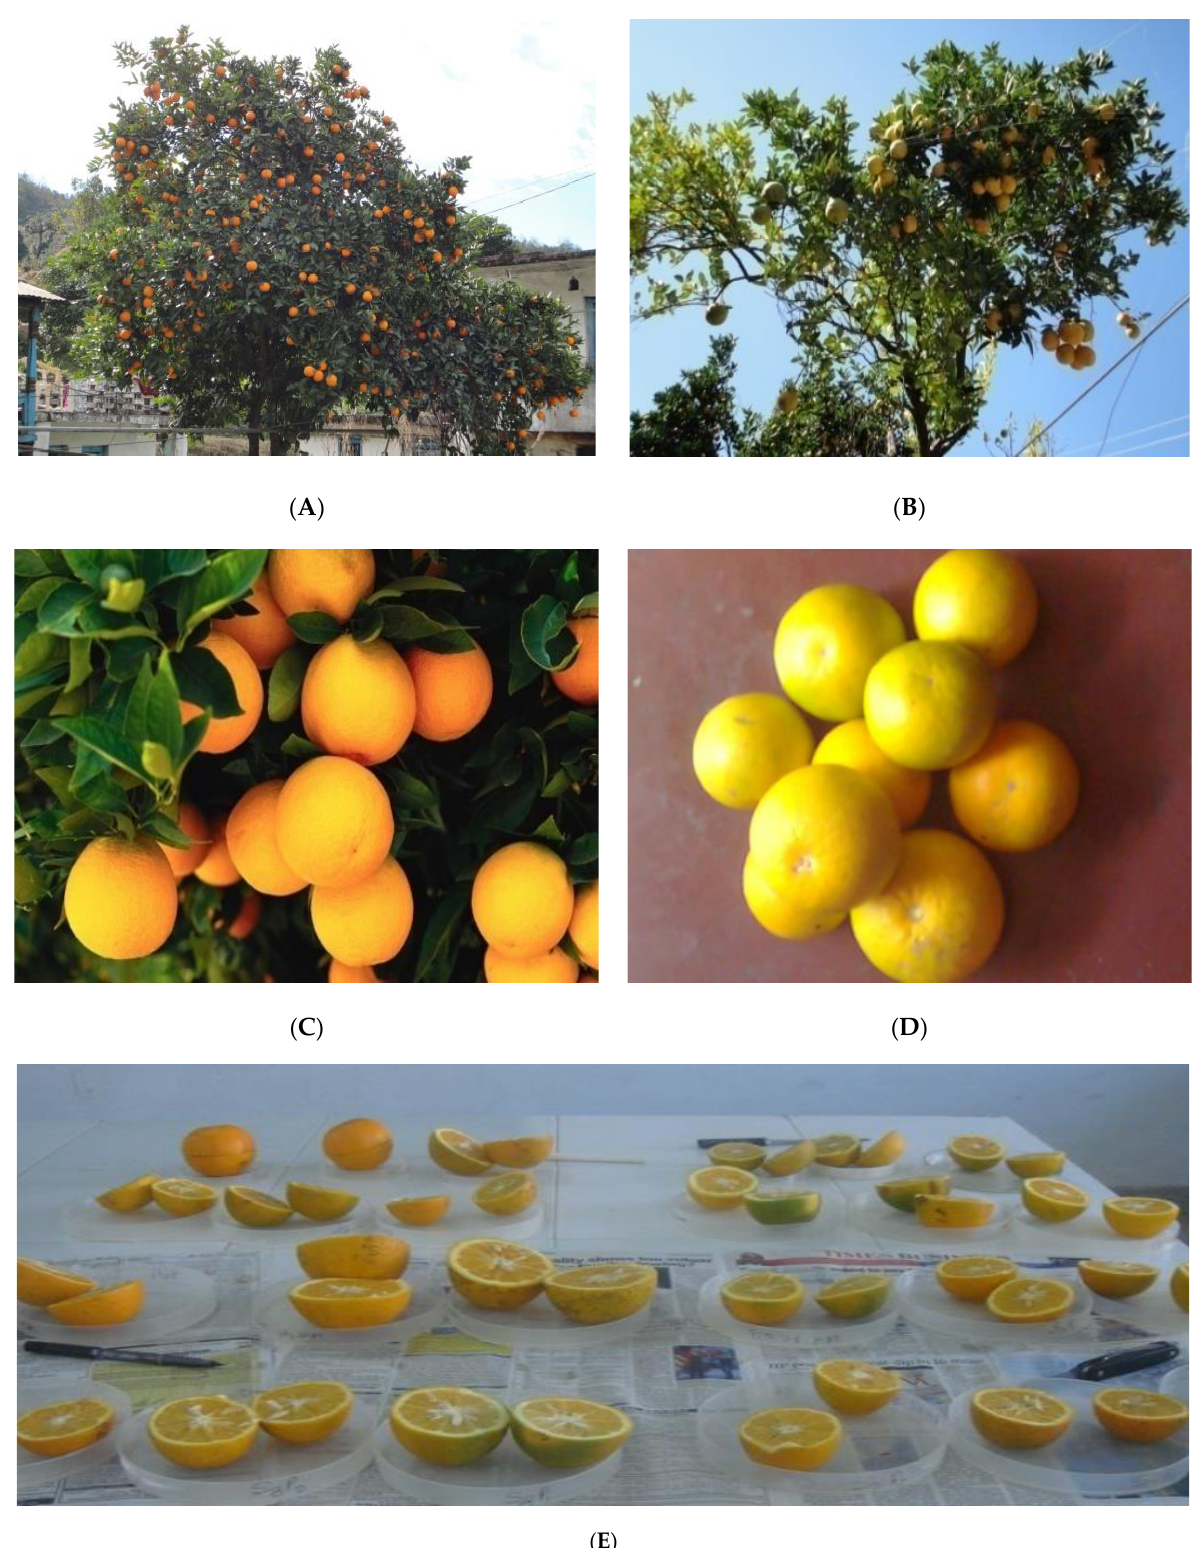
Figure 1. ( A ) Tree bearing C. sinensis fruits. ( B ) C. sinensis fruits turning colour; ( C ) C. sinensis at the harvesting stage; ( D ) Harevested fruits of C. sinensis ( E ) C. sinensis fruit samples for testing.